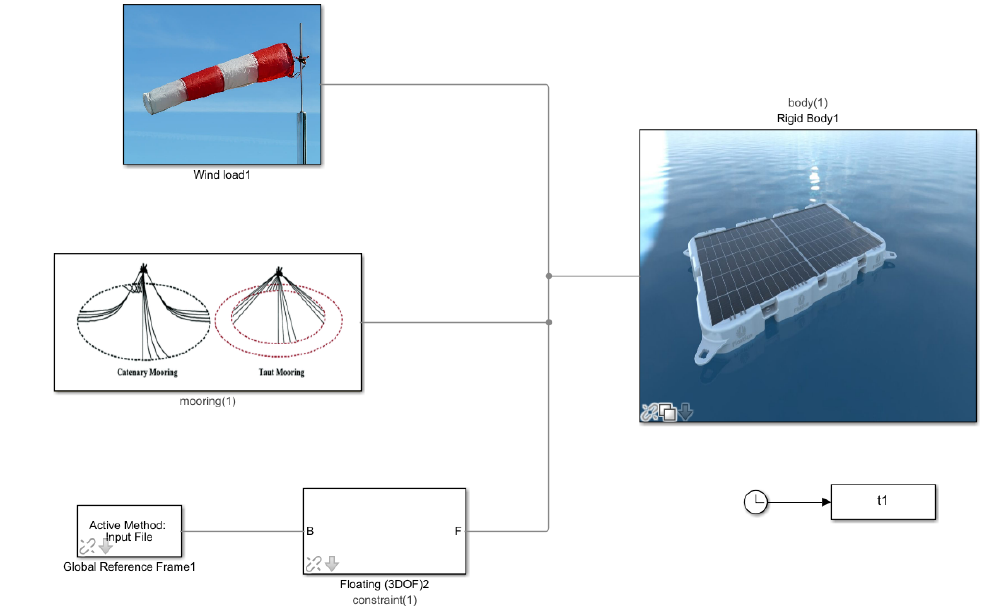
Figure 5. Numerical model of FPV